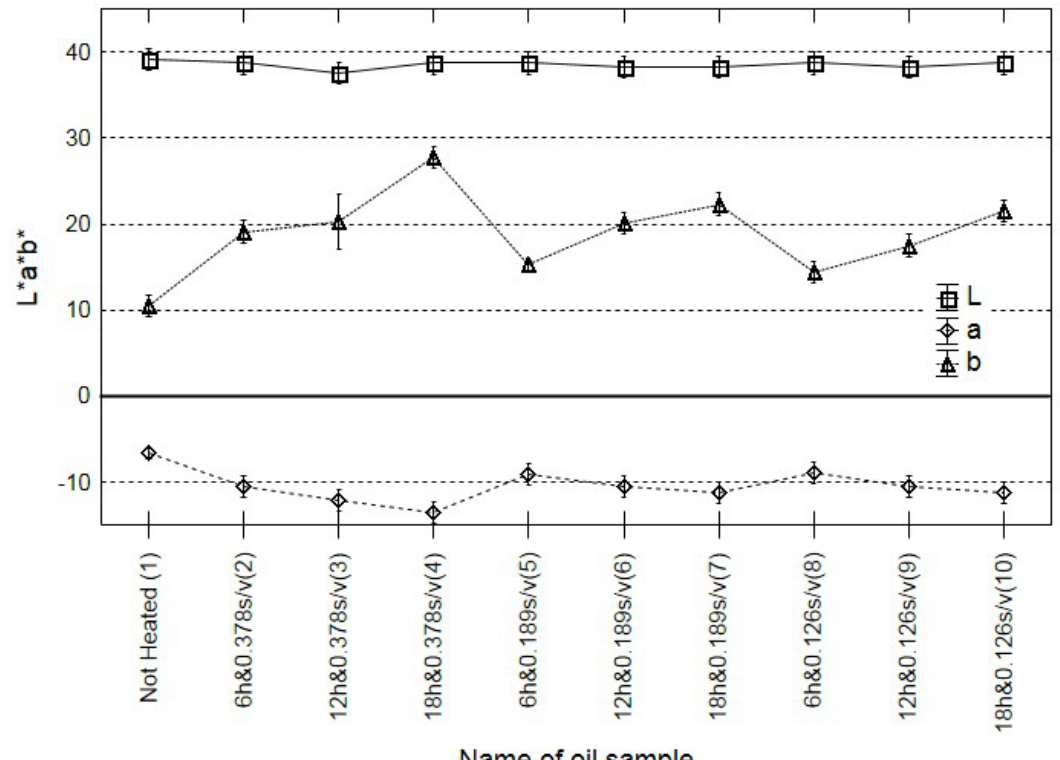
Figure 2. Changes in the colour (L a b) of all oil fried samples and the control.